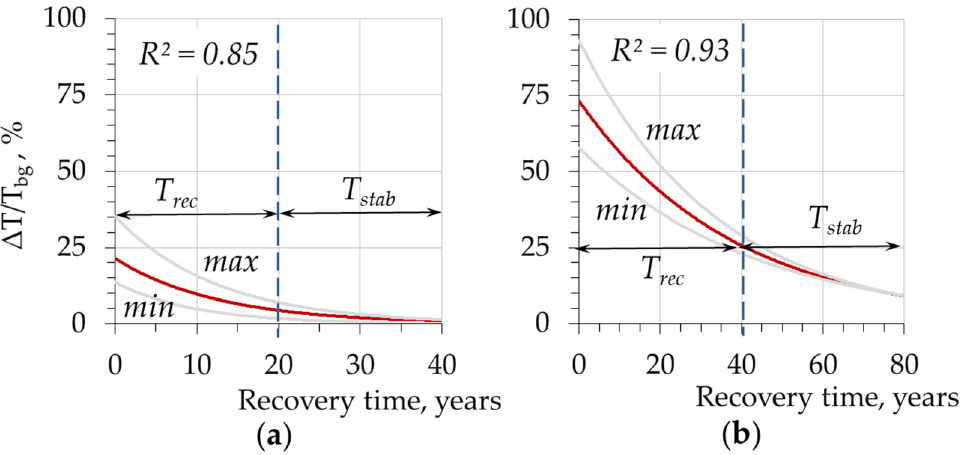
Figure 5. Long-term dynamics of surface temperature anomalies ( ΔТ /T bg , %) marked with the period of intensive recovery (T rec ) and stabilization time lag (T stab ) averaged for post-fire plots ( a ) and for post-technogenic plots ( b ).